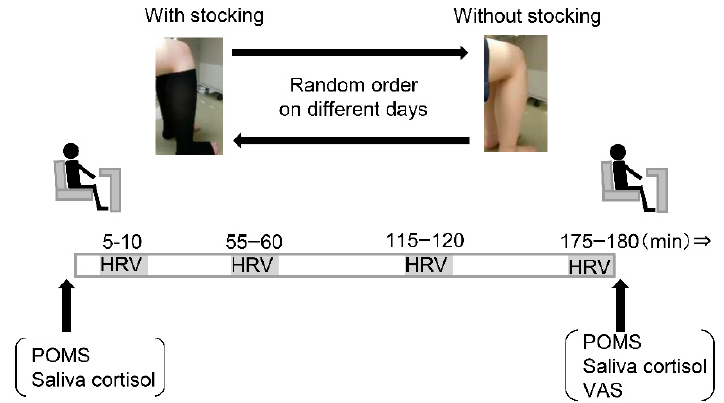
Figure 1. Illustration of experimental procedure. HRV, heart rate variability; POMS, Profile of Mood States; VAS, visual analogue scale.